Question: Which kind of chart has been used to present this data?
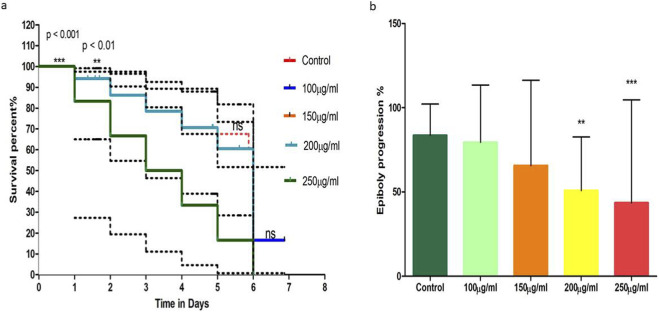
Answer: survival